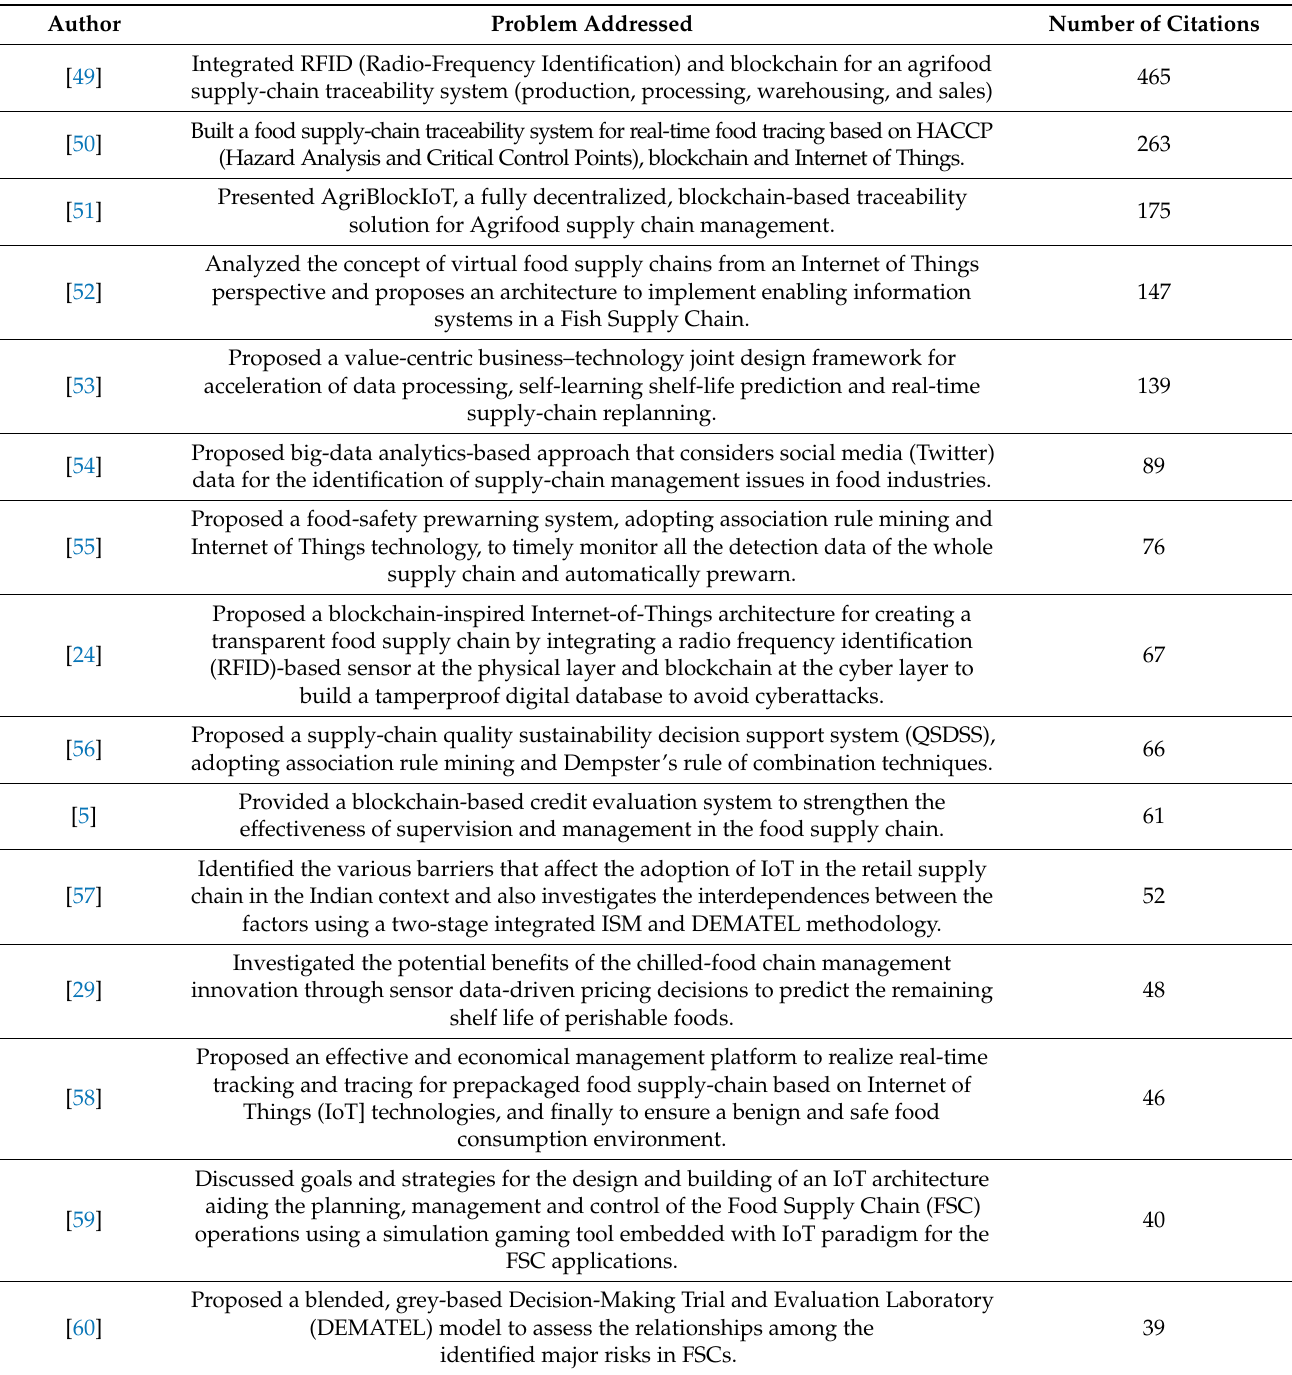
Table 2. Author (top fifteen) vs. Problem addressed vs.